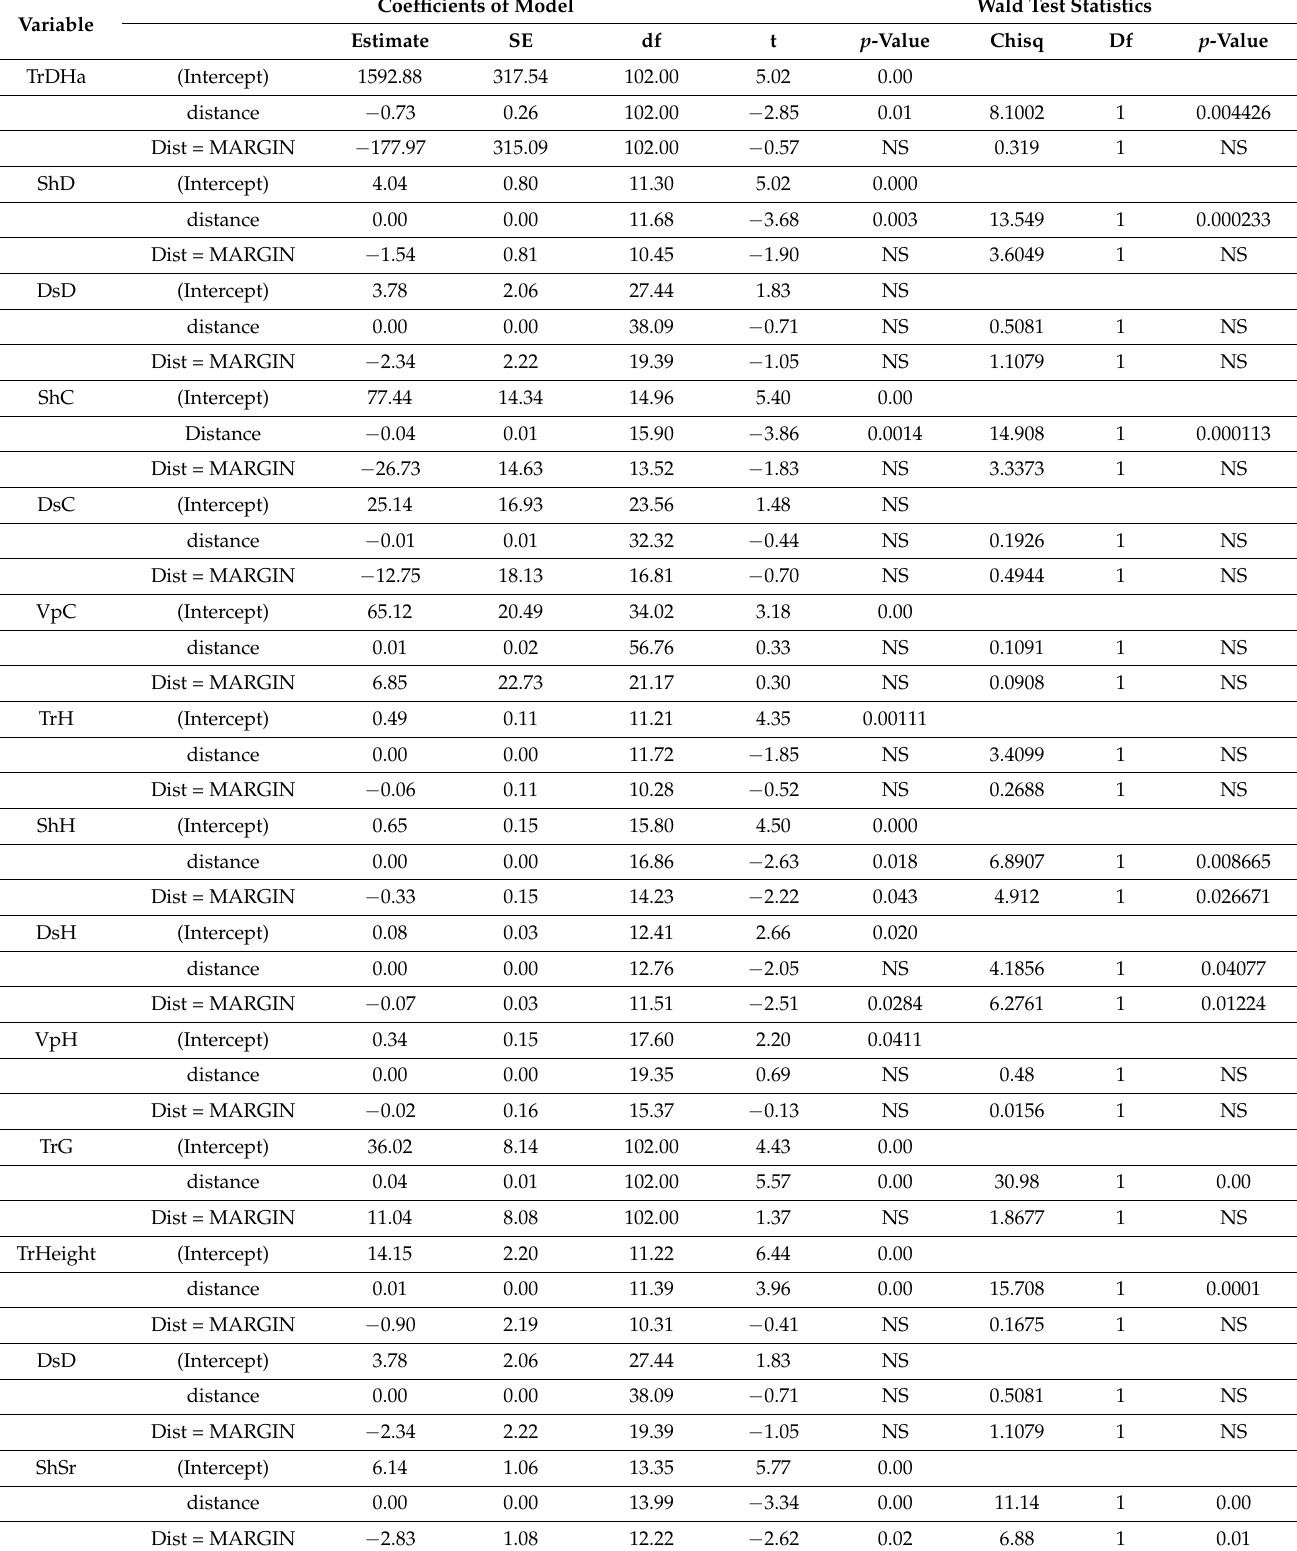
Table 5. Results of the LMM tests: coefficients and Wald test statistics. Codes of the variables (Table